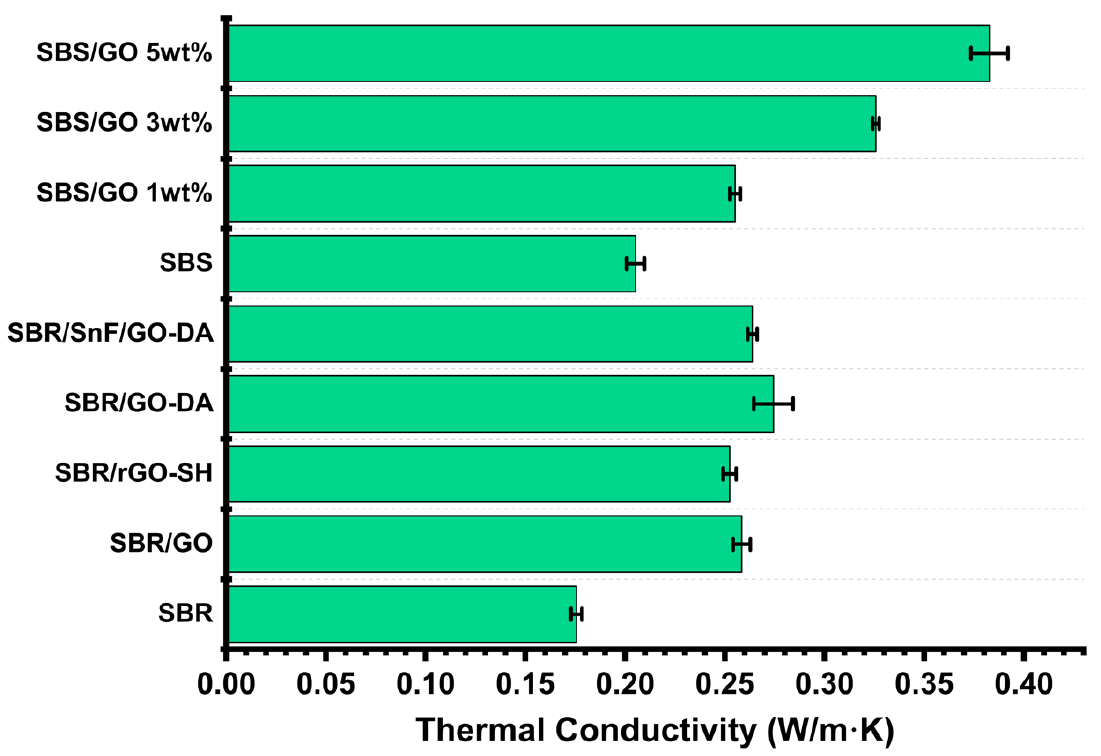
Figure 12. Thermal conductivity values for the SBR and SBS composites.